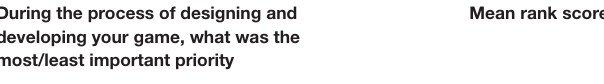
TABLE 1 | Priorities developers considered when designing/developing their game. During the process of designing and developing your game, what was